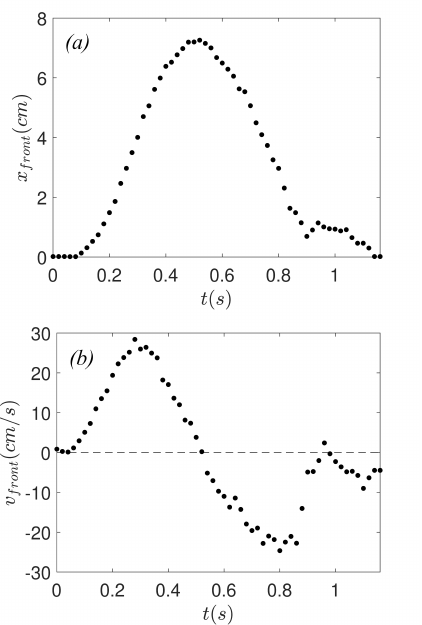
Figure 5. Time evolution of (a) the position, x front ( t ), and (b) the velocity v front = d x front / d t of the granular front for H 0 = 39 cm, L 0 = 14.5 cm and h 0 = 4 cm (regime III, for Fr 0 = 3 . 12 and Fr f = 1 .